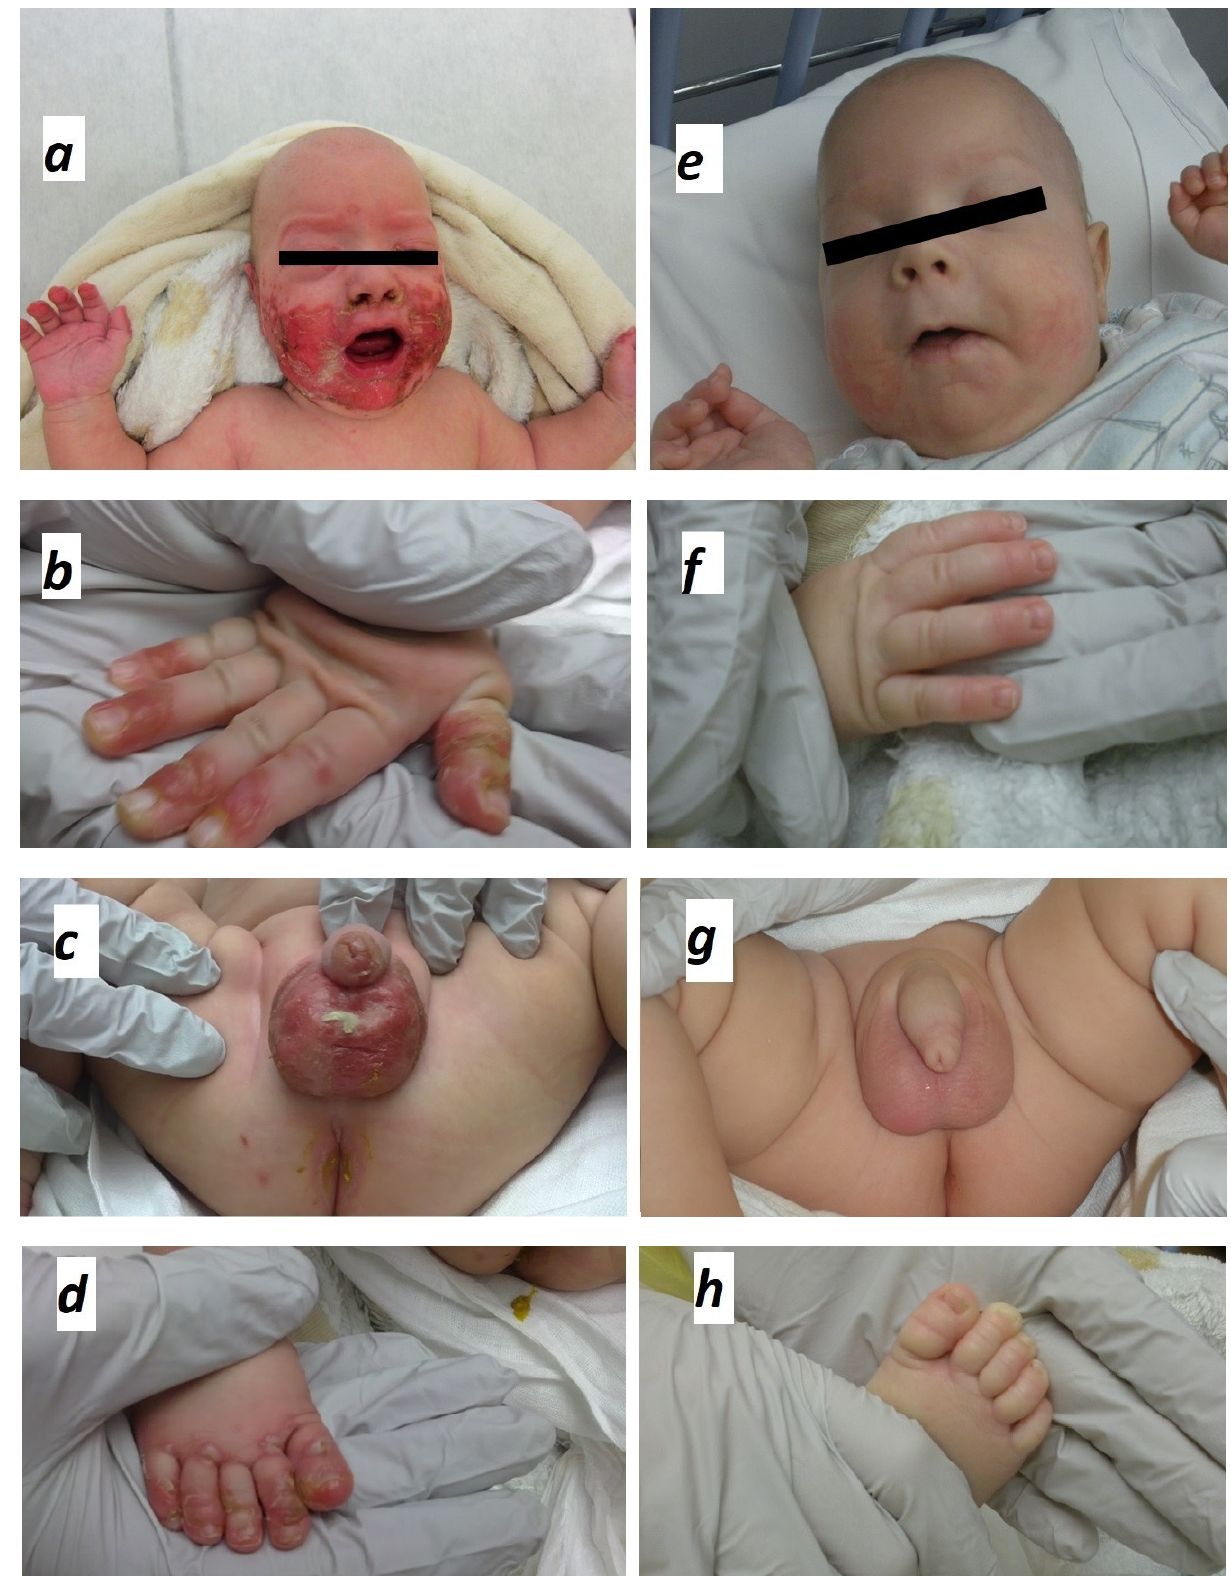
Figure 1. Clinical erosions and typical distribution of skin lesions at the initial presentation of zinc deficiency (panels a – d ) and healing after 2 weeks of zinc supplementation (panels e – h ).